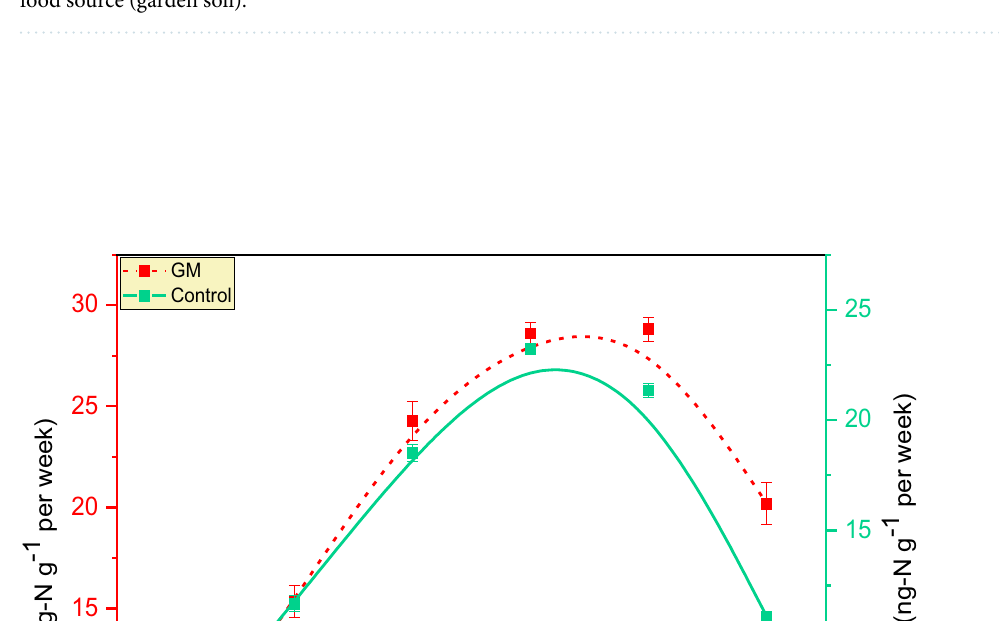
Figure 3. Temporal variation in denitrification rates (ng-Ng −1 per week) from coprolites of A. caligonosa by food source (garden soil).